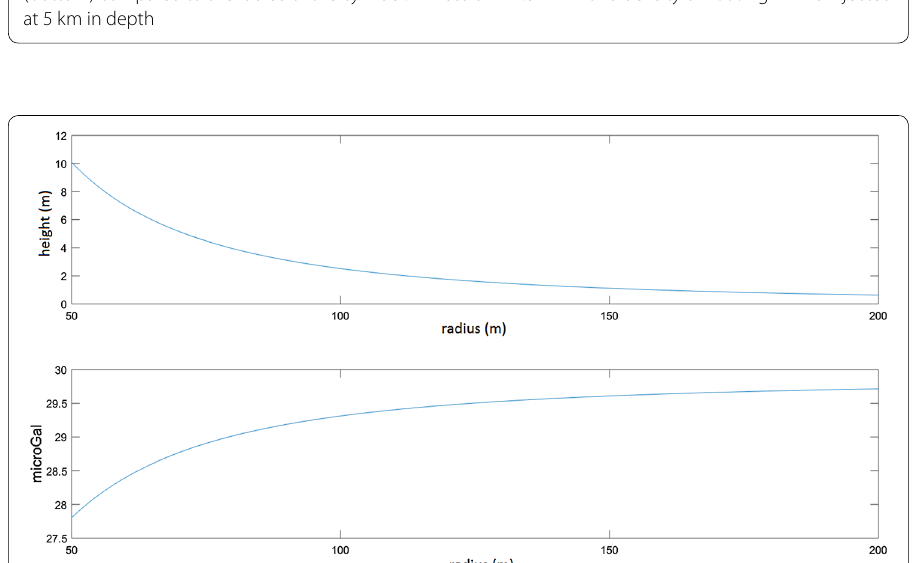
Fig. 14 Height of the cylinder (top) and gravity value at the ground level above the centre of the cylinder (bottom) compared to the cylinder radius. A mass of 84 kT with a density of 1060 kg m − 3 is injected at 137 m in